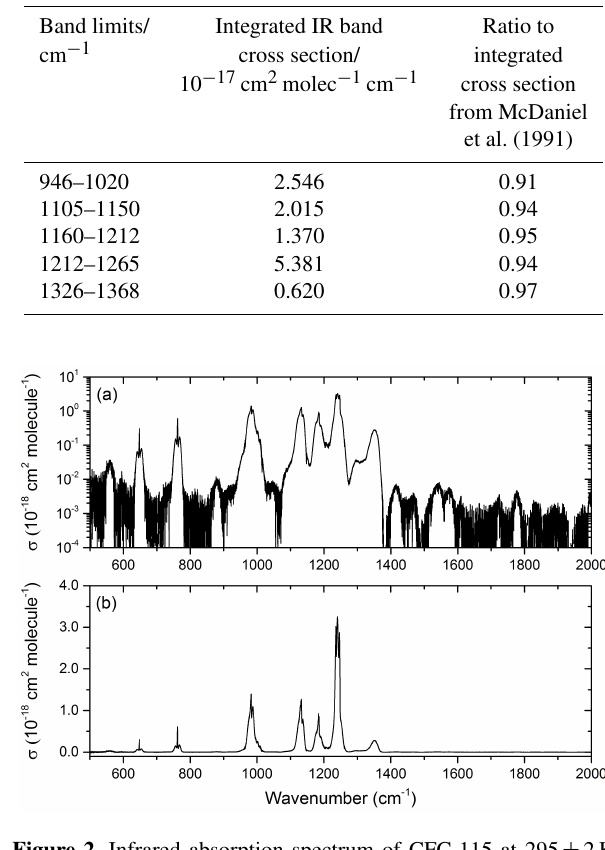
Figure 2. Infrared absorption spectrum of CFC-115 at 295 ± 2K on a logarithmic (a) and linear (b) scale. The logarithmic plot high- lights the minor